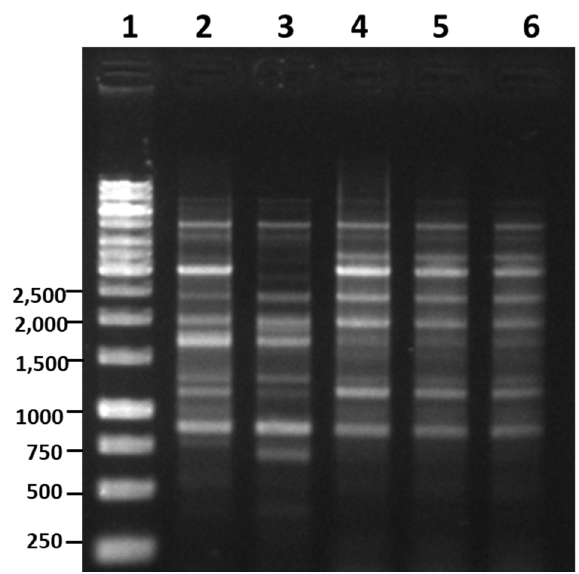
Figure 4. RAPD-PCR of various reference strains of Bacillus velezensis . Lane 1: 1 kb size ladder (unit: bp);